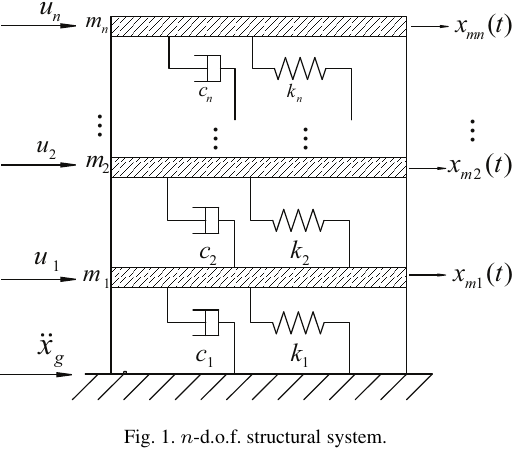
Fig. 1. n -d.o.f. structural